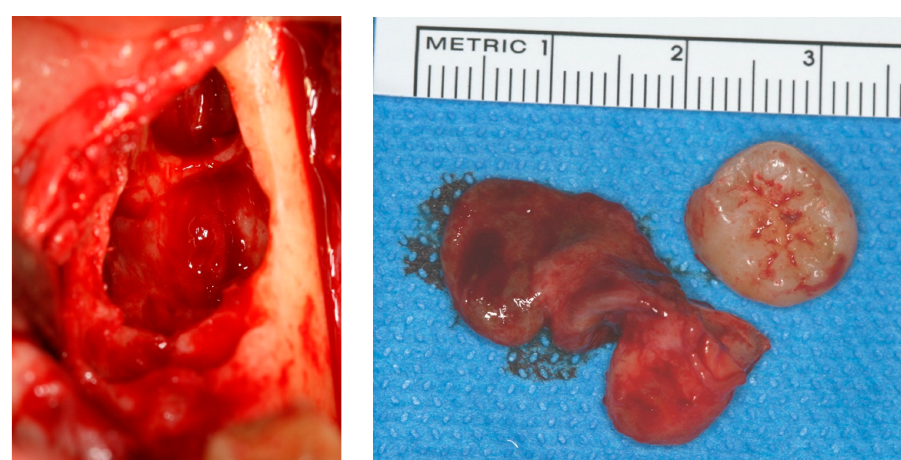
Figure 12. Avulsion of tooth 38 and in toto enucleation of the cyst in case